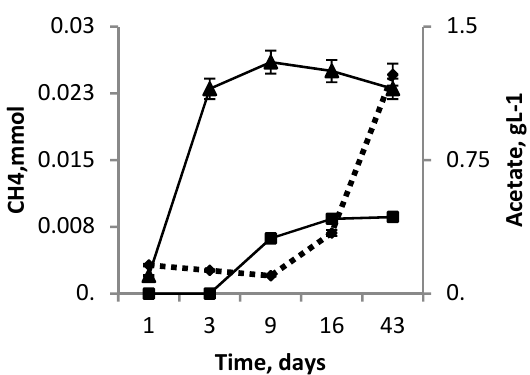
Figure 5. Methane formation by M. mazei JL01 (traingle) and acetate concentration (square) in a mixture with S. associata GLS2 T without substrate addition and acetate production (rhombus) by S. associata GLS2 T with xylose